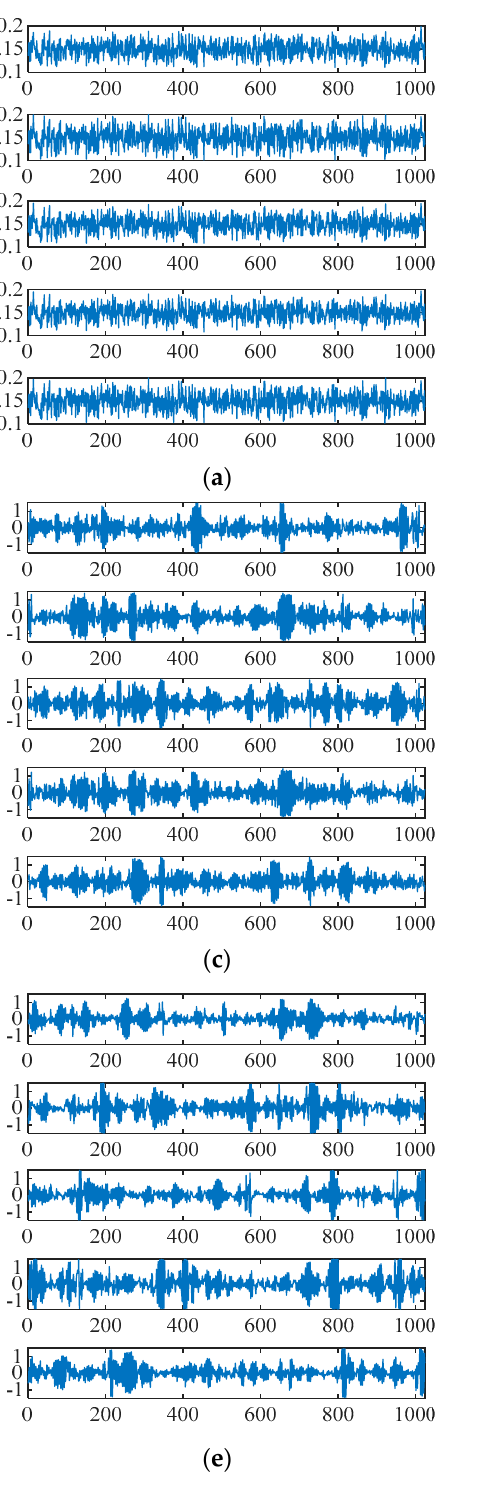
Figure 10. The generated signals vary with the number of iterations: ( a ) 10 iterations; ( b ) 5 × 10 3 iterations; ( c ) 5 × 10 4 iterations; ( d ) 8 × 10 4 iterations; ( e ) 1.2 × 10 6 iterations; and ( f ) 2 × 10 6 iterations.